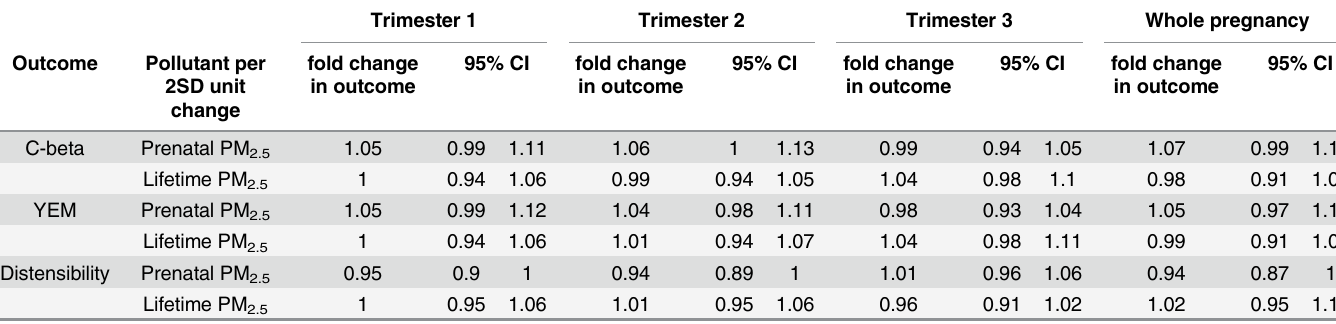
Table 3. The association between prenatal and postnatal PM 2.5 ( μ /m 3 ) exposures and CAS * (N = 724). Trimester 1 Trimester 2 Trimester 3 Whole pregnancy Outcome 95% CI fold change